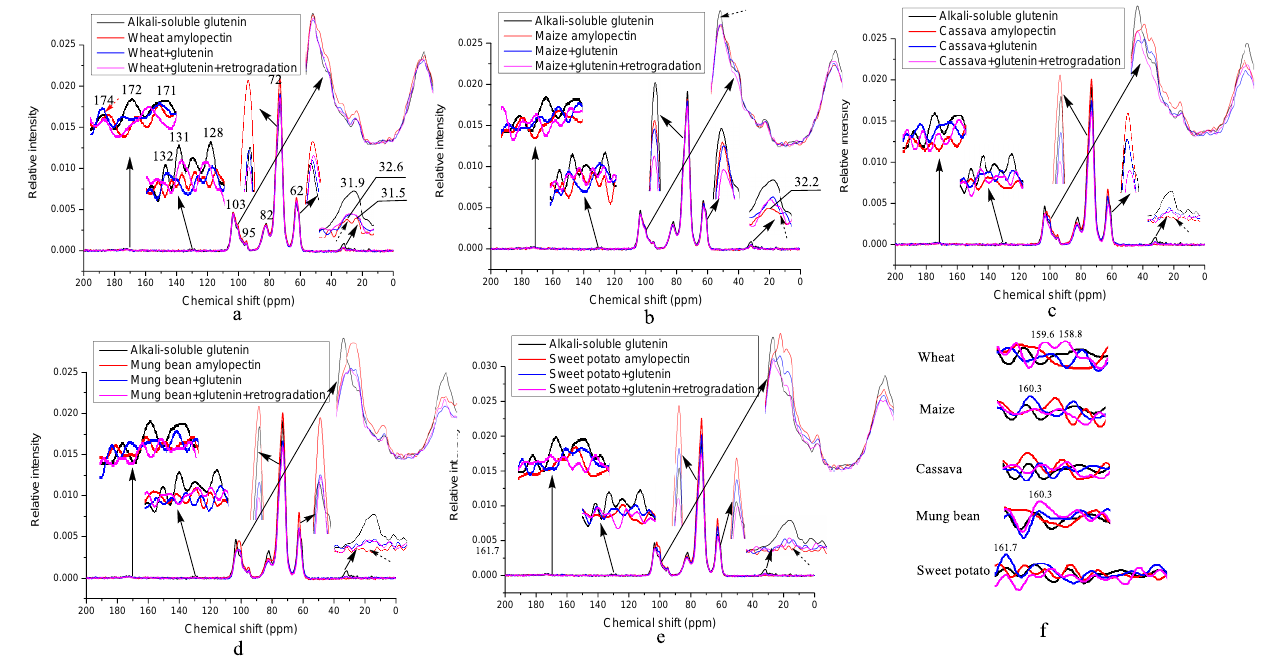
Figure 2. 13 C solid-state NMR spectra of different amylopectins mixed with and without alkali-soluble glutenin. The subfigures are the graphs of a particular peak magnified by a factor of 5–10. ( a ) wheat amylopectin group, ( b ) maize amylopectin group, ( c ) cassava amylopectin group, ( d ) mung bean amylopectin group, ( e ) sweet potato amylopectin group, ( f ) the changes of resonance for Y ζ (Tyr) of alkali-soluble glutenin during mixing and retrogra-dation. Result for alkali-soluble glutenin in Figure 2a–f is from the same sample, addition of it in every figure is to facilitate comparative analysis. Table 5 shows the detailed information about the resonance changes of all the